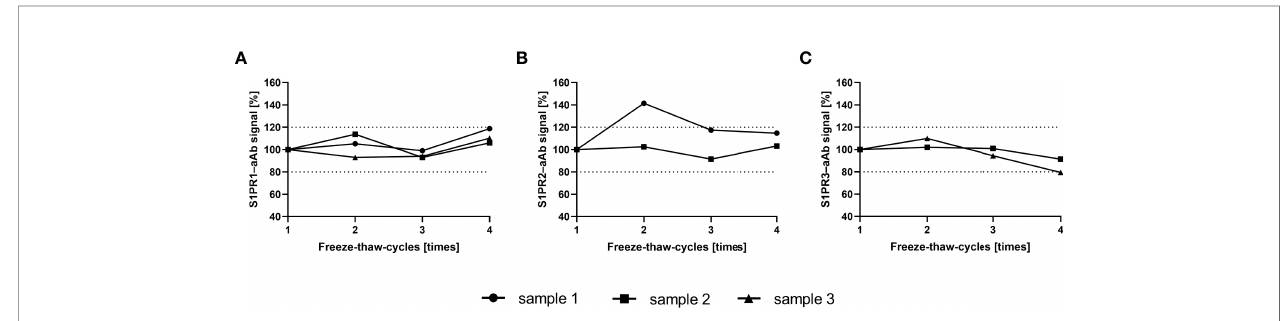
FIGURE 2 | Signal stability upon multiple freeze-thaw-cycles. S1PR – aAb signal stability of aAb-positive serum was assessed with selected samples in the newly generated assays for (A) S1PR1 – aAb, (B) S1PR2 – aAb, and (C) S1PR3 – aAb assay. Samples were subjected consecutively to four freeze and thaw cycles, and all measurements with one exception displayed signal intensities within a 20% range from the initial signal strength determined upon fi rst thawing.